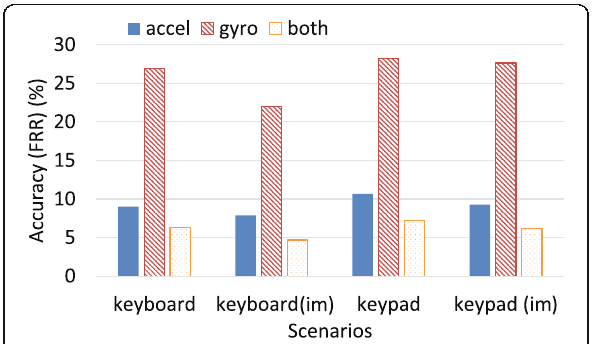
Fig. 9 The accuracy (FRR) when using only one sensor Fig. 10 Inter-keystroke timings of an original user and the